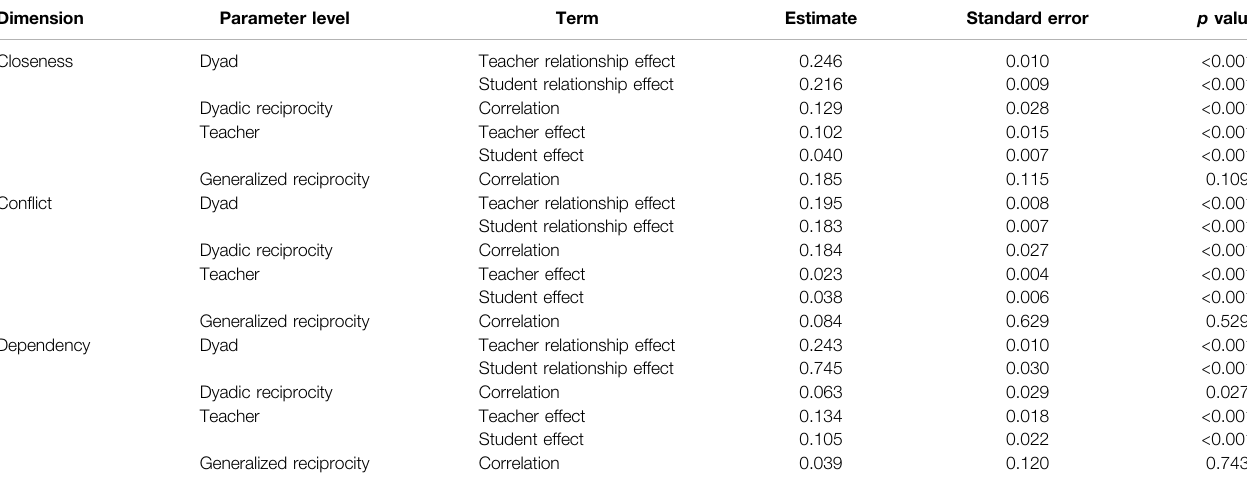
TABLE 3 | Estimates of variance and correlational parameters. Dimension